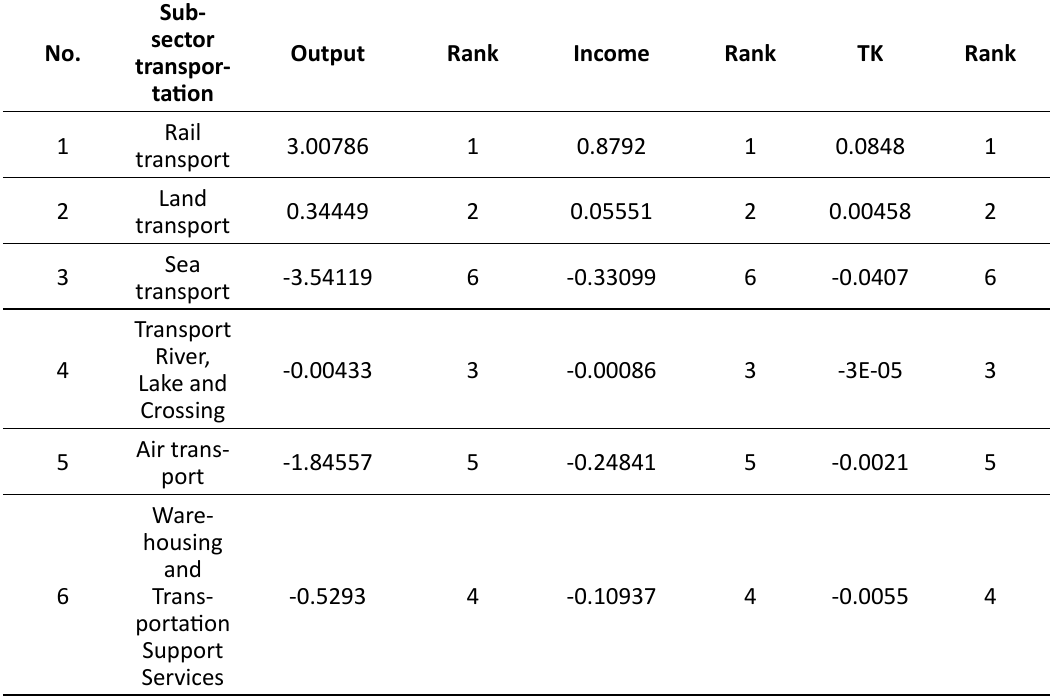
Table 4: Transportation Sub-sector Multiplier Value in Indonesiain 2010